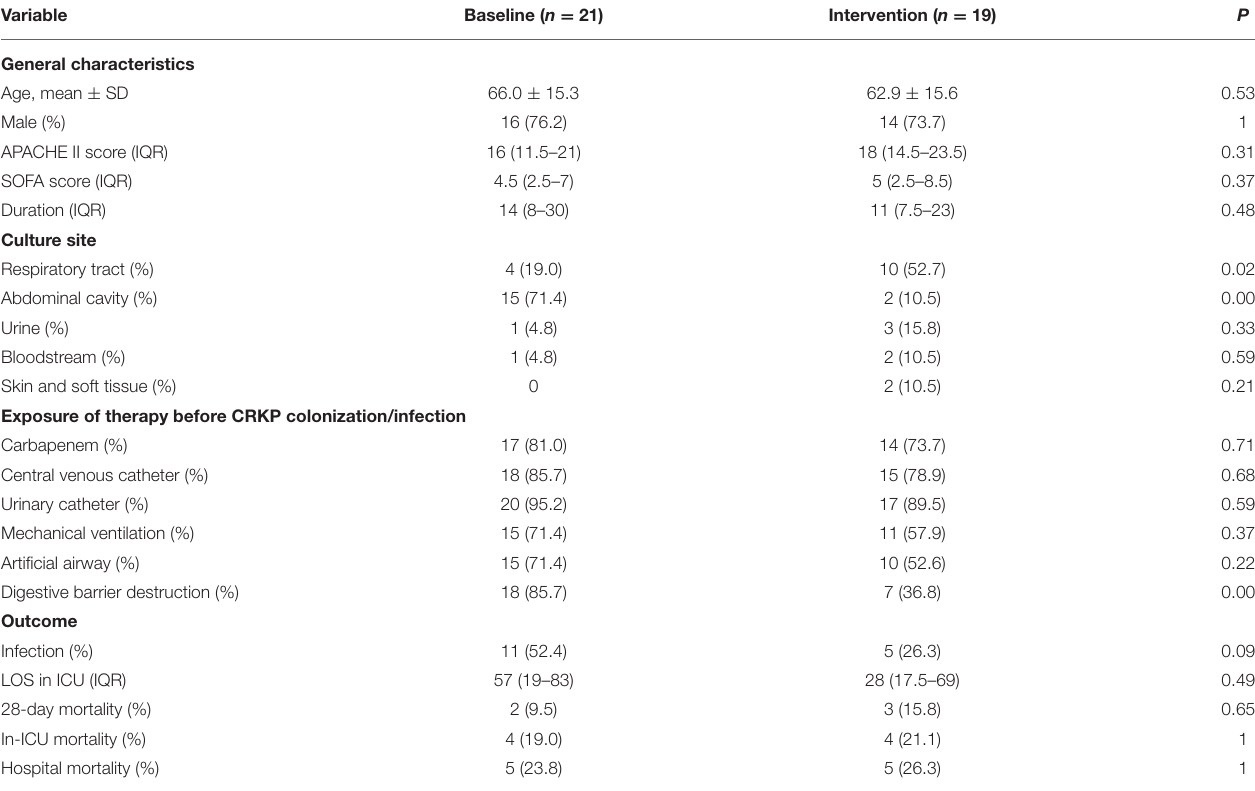
TABLE 2 | Clinical characteristics of the patients with ICU-acquired carbapenem-resistant Klebsiella pneumoniae (CRKP). Variable